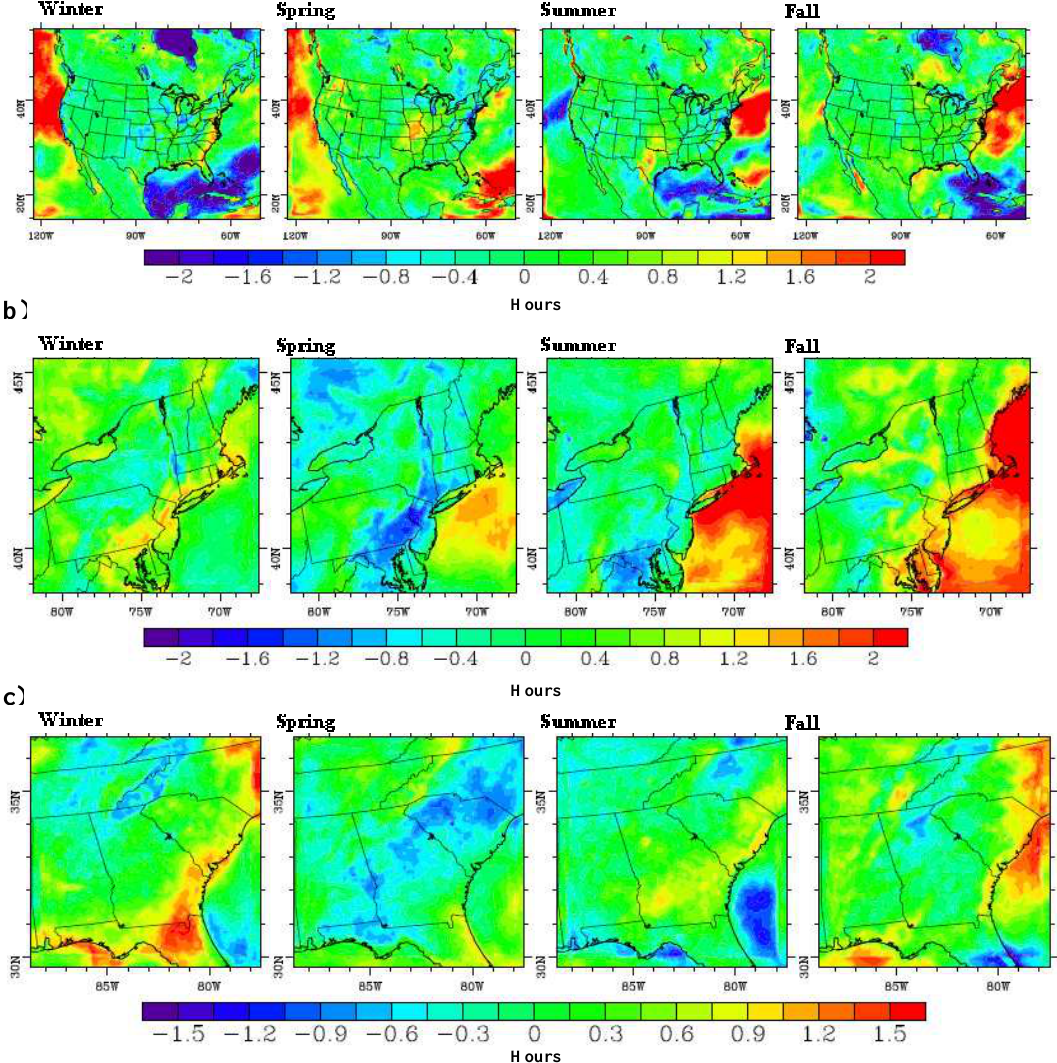
Fig. 6. Predicted total seasonal change in average unvented hours (hours per day) (future minus historic) for (a) the 36km × 36km resolution modeling domain, (b) the 12km × 12km resolution sub-domain over the Northeast and (c) the 12km × 12km resolution sub-domain over the Southeast.